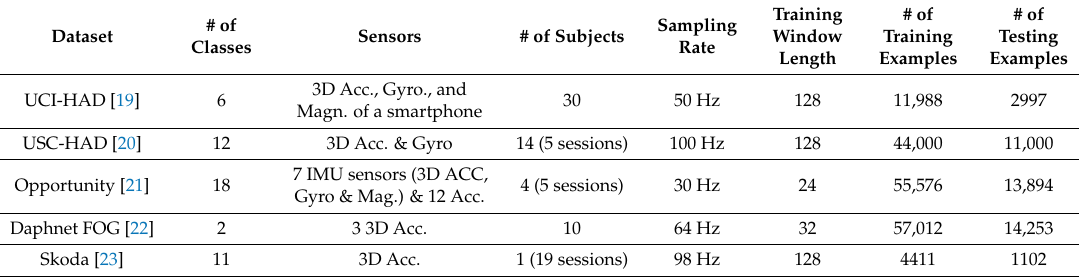
Table 1. Summary of human activity datasets used to evaluate the proposed deep learning models. Training window length indicates the number of samples in a window that we found to yield the best results for each dataset. Each dataset was divided into 80% for training and 20% for